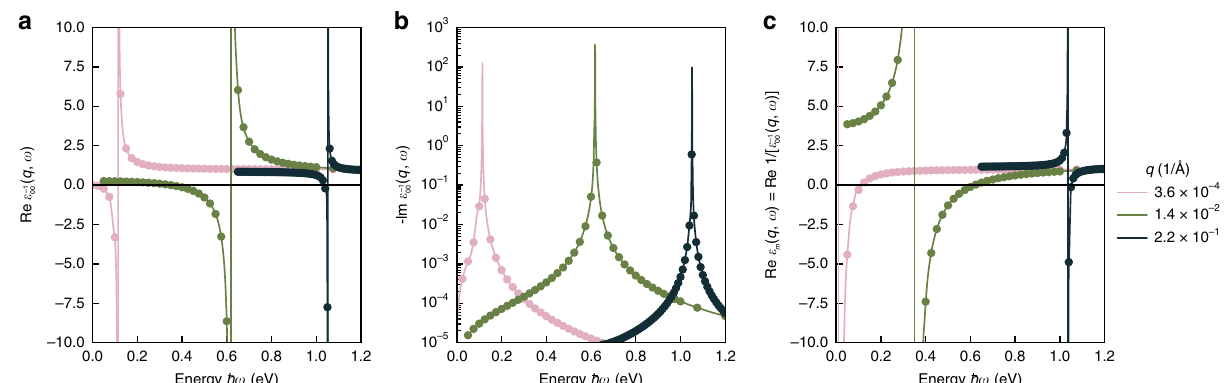
Fig. 6 Dielectric response matrices computed from fi rst principles for monolayer TaS 2 in a supercell arrangement with a cell length of L = 100 Å along the direction normal to the layer and with numerical broadening of 0.1 meV. a Real and ( b ) imaginary parts of the G = G ’ = 0 components of the inverse dielectric matrices of such dilutely stacked monolayers for three different in-plane wavevectors q , where G is a reciprocal lattice vector of the quasi-2D crystal. The imaginary part plotted in panel ( b ) is proportional to the loss function, the sharp peaks of which are associated with plasmon excitations. c Real part of the macroscopic dielectric matrix, the zeros of which are associated with plasmon collective excitations. While the absolute values of dielectric matrices depend on the stacking spacing and broadening parameter used in our supercell calculations, the poles in panels ( a ) and ( b ), as well as the zeros in panel ( c ), are not sensitive to such